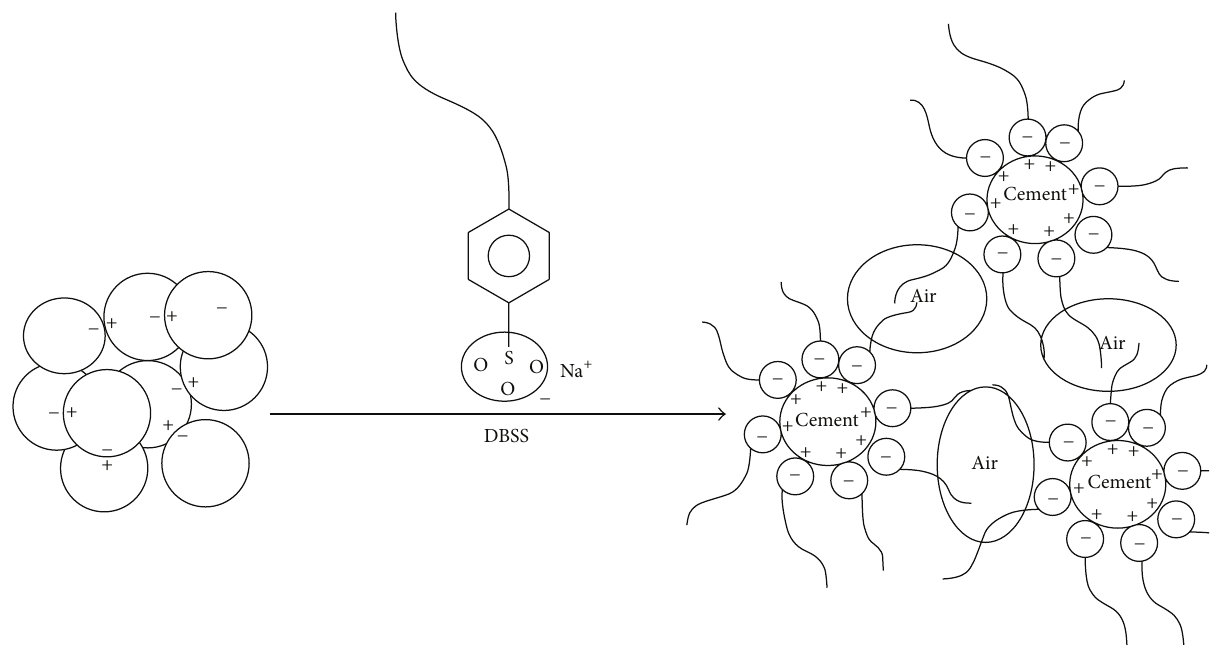
Figure 2: Mechanism of anionic surfactant (DBSS) with negative charge in mortar acting as an air entrainment.